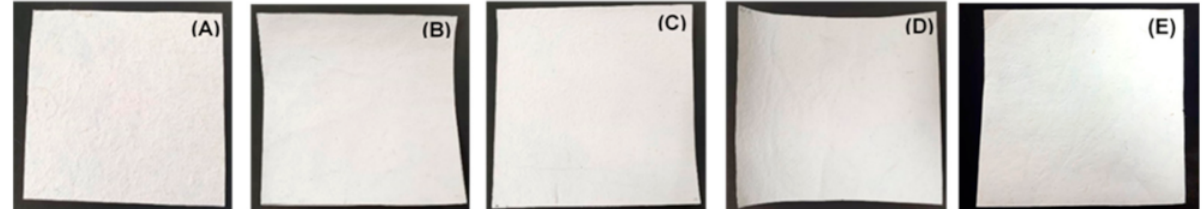
Figure 1. Visual appearance of ( A ) the non-coated PLFP, ( B – D ) the commercial P(3-HB) coated PLFPs at 5, 7.5 and 10% ( w/v ) and ( E ) the biosynthesized P(3-HB) coated PLFP at 7.5% ( w / v